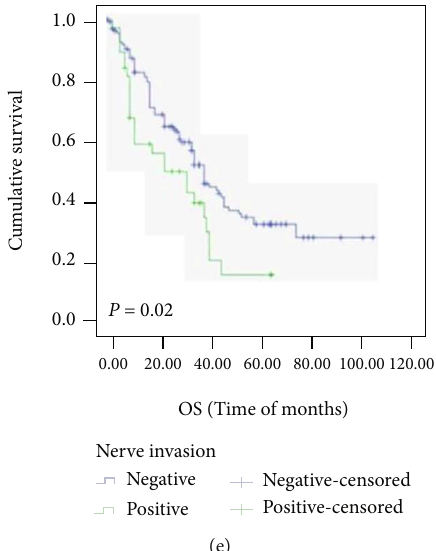
Figure 2: OS analysis of patients ’ clinicopathological parameters with ESCC using the Kaplan – Meier method. Notes: OS according to (a) age ( P = 0 : 02 ), (b) tumor size ( P = 0 : 04 ), (c) degree of di ff erentiation ( P = 0 : 04 ), (d) lymph node metastasis ( P = 0 : 003 ), and (e) nerve invasion ( P = 0 : 02 ). Abbreviations: OS: overall survival; PFS: progression-free survival; ESCC: esophageal squamous cell